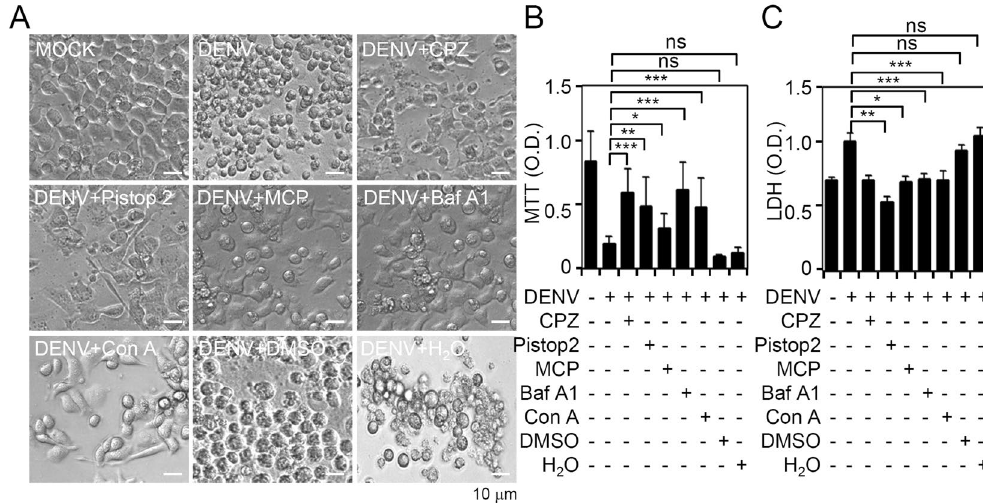
Figure 5. Pharmacologically targeting endocytic pathways reduces dengue virus serotype 2 (DENV2)- induced neurotoxicity in vitro . Following pretreatment with chlorpromazine (CPZ; 5 ng/ml), Pitstop2 (30 µ M), metoclopramide (MCP; 10 µ M), BafA1 (100 nM), or concanamycin A (ConA; 50 nM), ( A ) cell morphology, ( B ) MTT, and ( C ) lactate dehydrogenase (LDH) assays respectively show cell growth, viability, and cytotoxicity in DENV (at a multiplicity of infection of 10)-infected cells at 72 h. For all images, representative data were selectively obtained from three individual experiments. All quantitative data are shown as the mean ± SD of three independent experiments. * p < 0.05, ** p < 0.01, and *** p < 0.001. ns, not